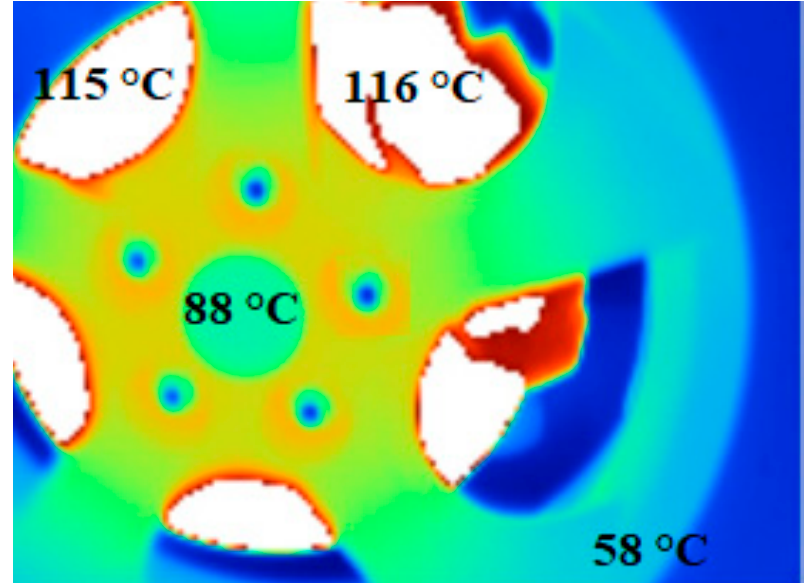
Figure 9. Other vehicle parts and brake discs heating up.